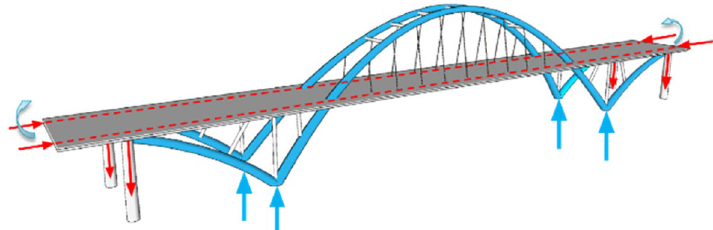
Fig. 11 Force transfer in a three-span half-through arch